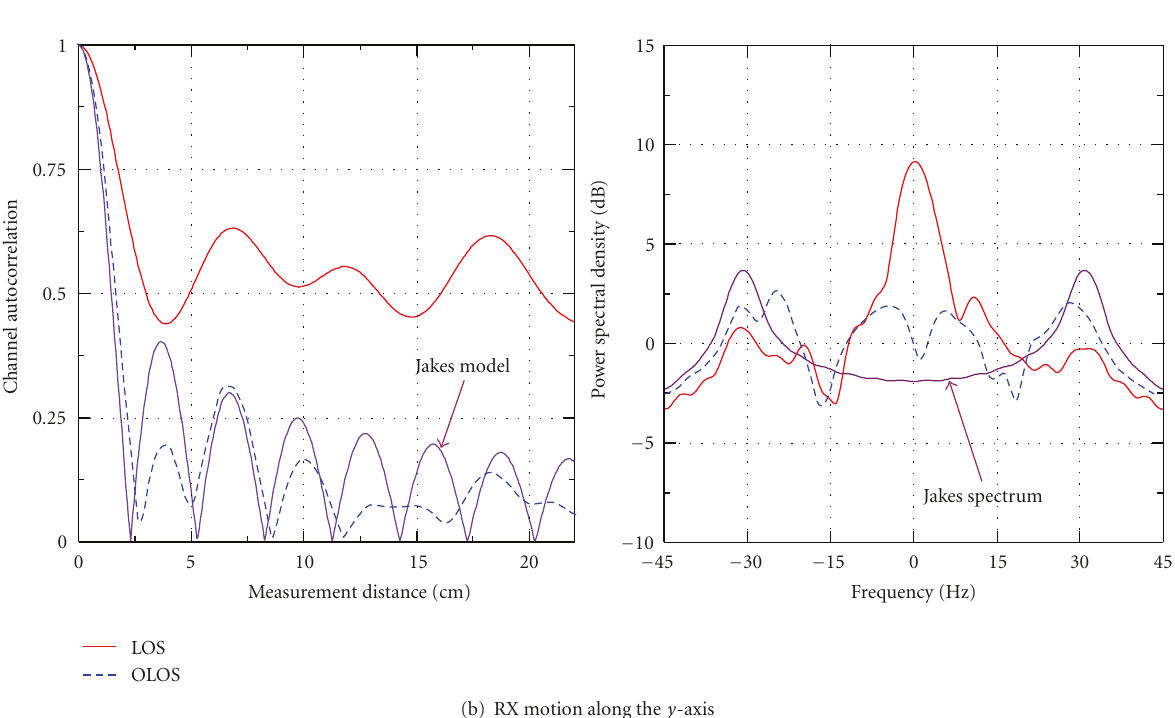
The signal-to-noise power ratio of the k th detected where P s = E [ | s 1 ( t ) | 2 ] = · ·· = E [ | s K ( t ) | 2 ], and σ 2 is substream is given by noise power. This indicates that the quality of each detected substream is di ff erent. Therefore, the channel capacity and λ k P k P s performance of MIMO E-SDM systems can be improved by , (7) γ k = adapting the TX data resource and power allocation σ 2